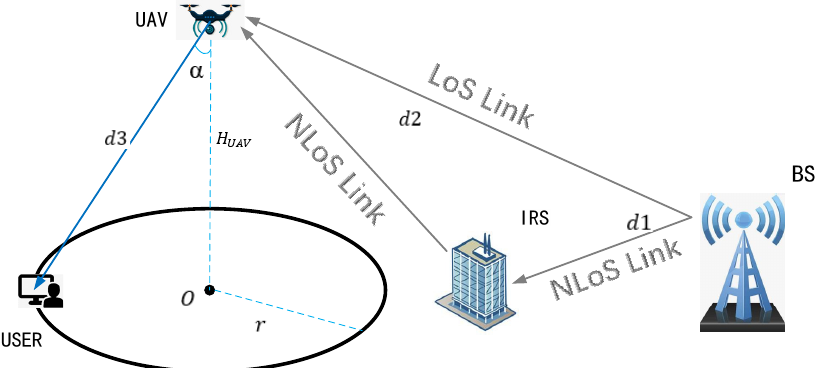
Figure 1. UAV-based cellular data network using an IRS